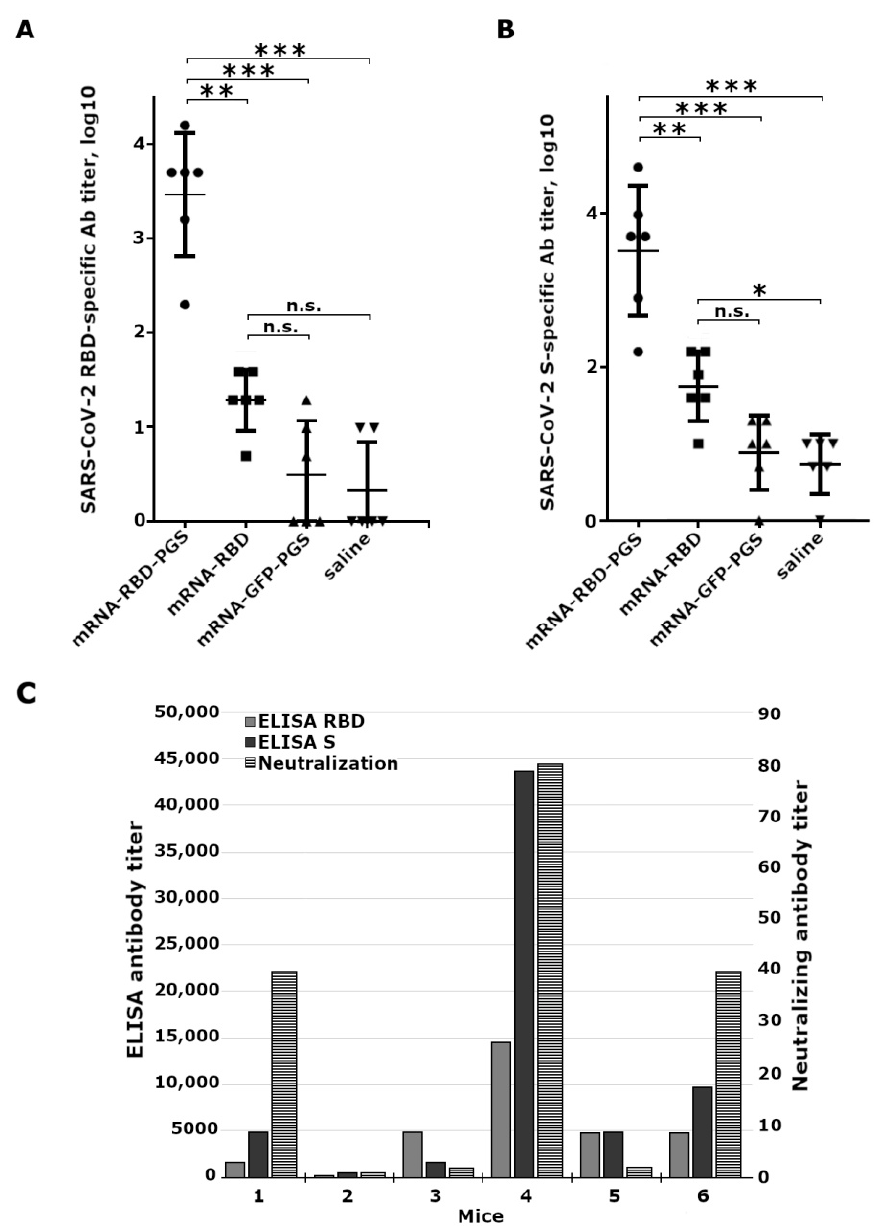
Figure 3. Humoral responses to SARS-CoV-2 antigens in immunized BALB/C mice. Mice were immunized intramuscularly with naked mRNA-RBD, complexes of mRNA with conjugate polyglucin:spermidine (mRNA-RBD-PGS or mRNA-GFP-PGS), or saline, three times at 0, 21, and 35 days (10 µ g mRNA per mouse). Sera samples were collected on mice 48 days after the first immunization. ( A ) The SARS-CoV-2 RBD specific IgG antibody titers and ( B ) the SARS-CoV-2 S specific IgG antibody titers were determined by ELISA. Statistical analysis was performed using GraphPad Prism 6.0 software. Data are presented as mean ± standard error of the mean. Significance was calculated using two-way analysis of variance with multiple comparison tests (n.s., not statistically significant; * p < 0.05, ** p < 0.01, *** p < 0.001). ( C ) Data of ELISA and virus neutralizing activity of sera from mRNA-RBD-PGS immunized mice. Abscissa axis: 1–6—mouse number. The left ordinate axis is the reciprocal antibody titer obtained by ELISA, the right ordinate axis is the reciprocal value of the neutralizing serum titer: grey bar—anti-RBD specific antibodies, white bar—anti-RBD specific antibodies, black bar—virus-neutralizing antibodies.